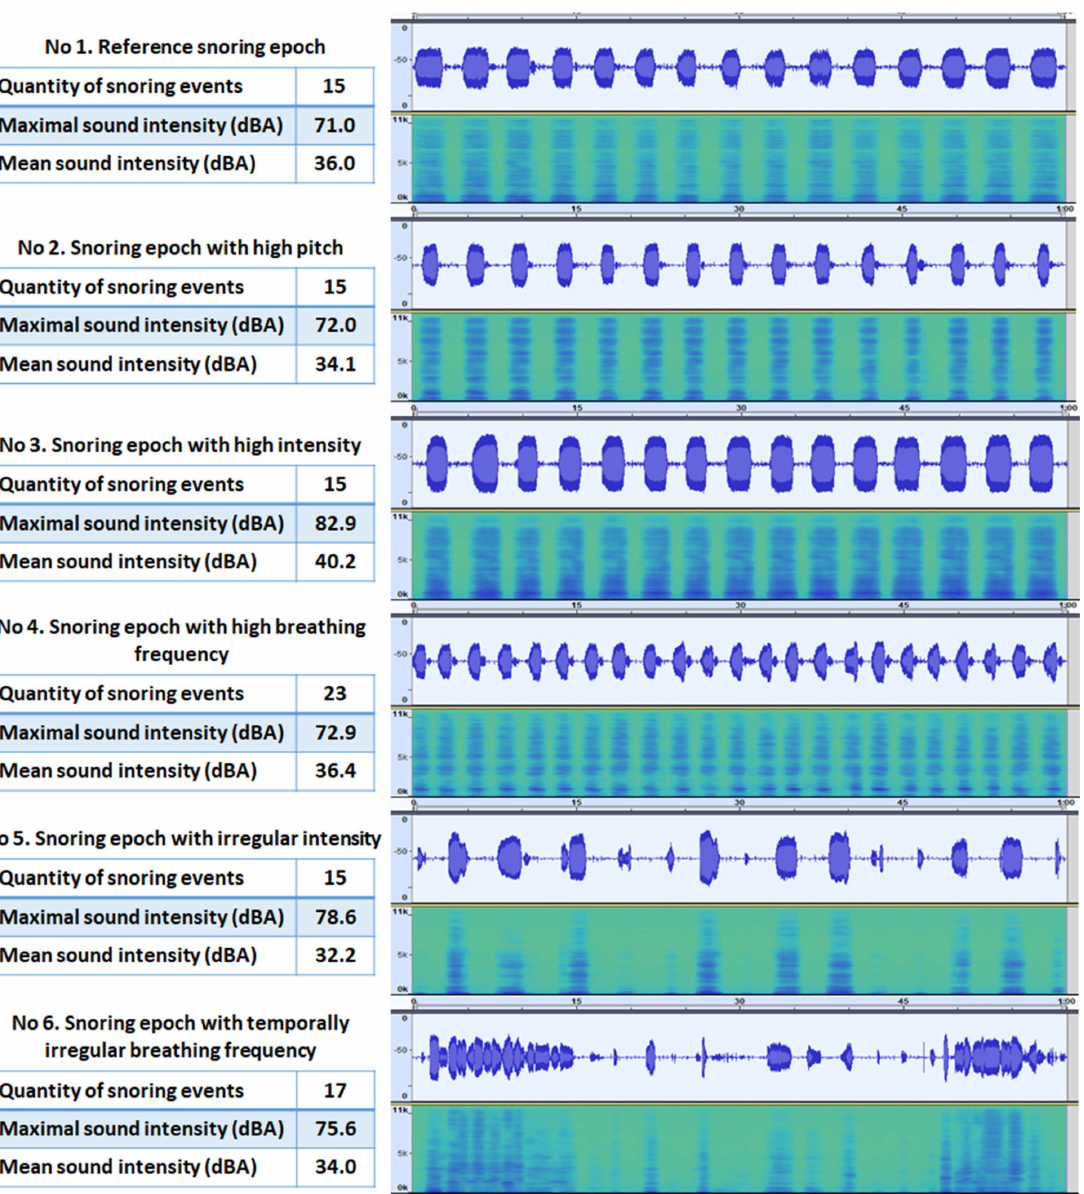
Figure 1. The six snoring epochs used in this study. Descriptive information of the snoring epochs (viz., quantity of snoring events, maximal sound intensity, and mean sound intensity) is shown on the left side. On the right side, the waveforms of the snoring epochs are shown in the upper panels (with white background); the amplitudes of waveforms represent the intensities of snoring sounds. In the lower panels (with green background), the spectra show the frequency distribution (0–11 kHz) of the snoring epochs. The blue horizontal lines represent the power of the sound, i.e., the bluer the horizontal lines at certain frequency, the higher power the sound has at this